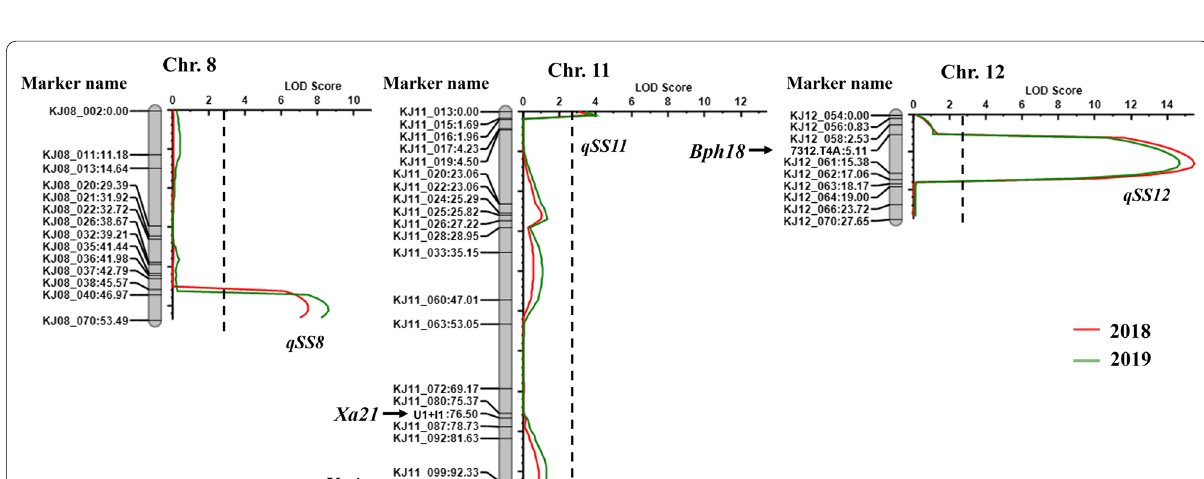
PVE (%): Percentage of phenotypic variation explained by the QTL, Add: additive effect